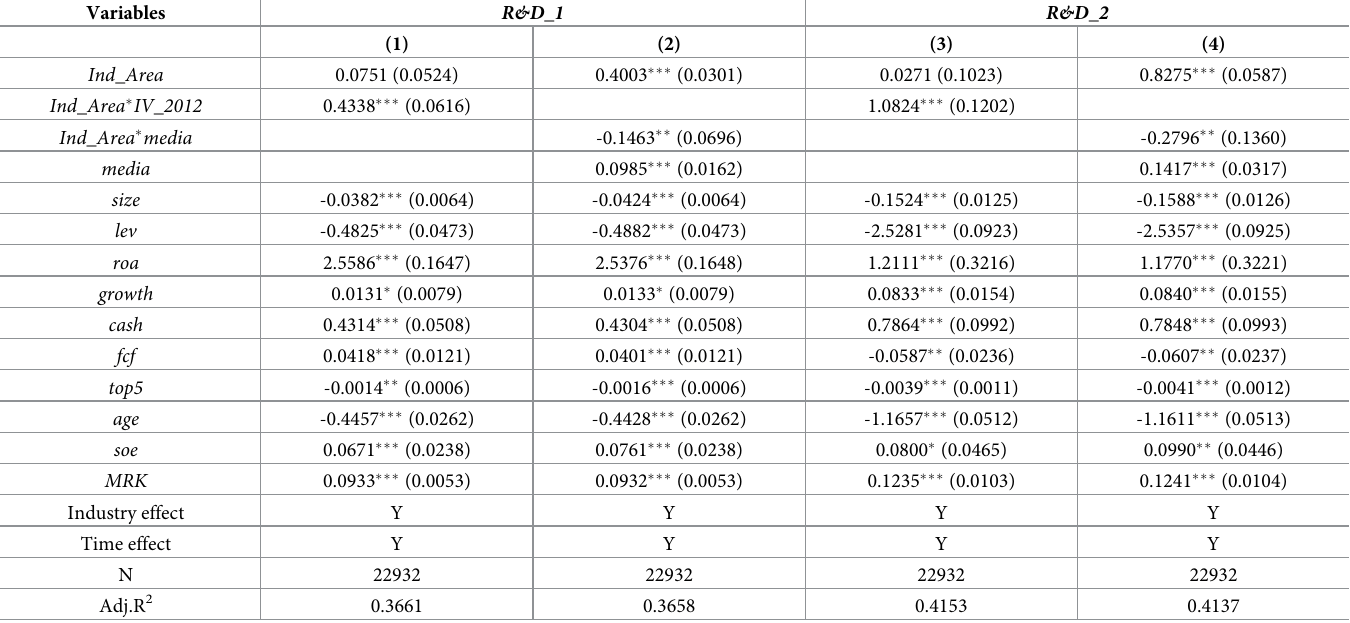
are 0.4338 and 1.0824, which are both significant at 1%. The results indicate that the ripple Table 6. The effect of CEO awards’ gold content and social awareness of